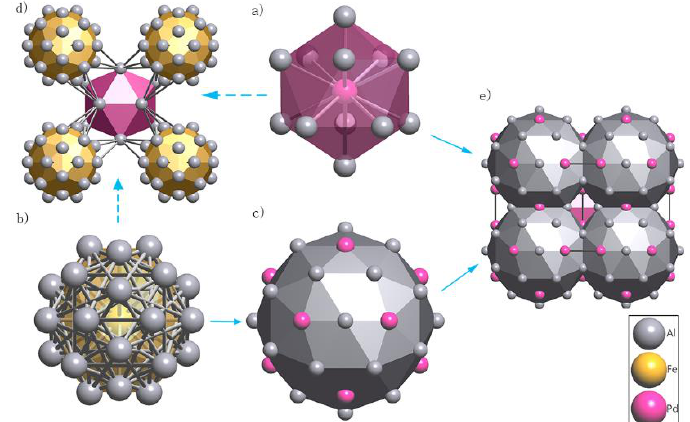
Figure 4. Building units and their packing around high symmetric positions in the C′ -phase. ( a ): the first building unit which is an icosahedra cluster; ( b ) the inner-shell of the second building unit; ( c ) the outer-shell of the second building unit; ( d ) packing pattern of one first building unit and four inner-shells; ( e ) packing pattern of one first building unit and four second building units.